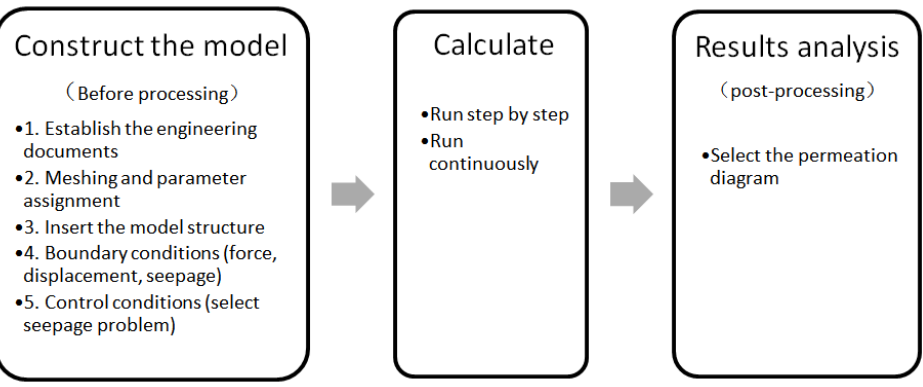
Figure 6. Problem analysis process of RFPA 2D gas plate software.